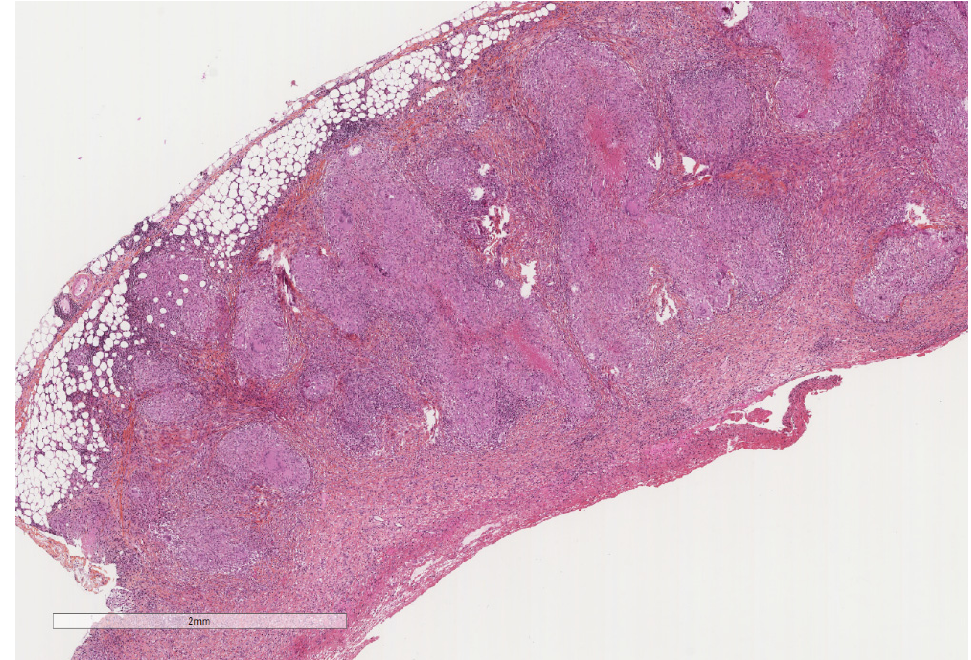
Figure 4. A severely thickened parietal pleura due to multiple nodules (see next figure for higher magnification). The adipose tissue is seen at the upper part of the image, while a fibrinous material covers the pleural cavity surface (lower part of the image). Hematoxylin, eosin, saffron staining ( ×